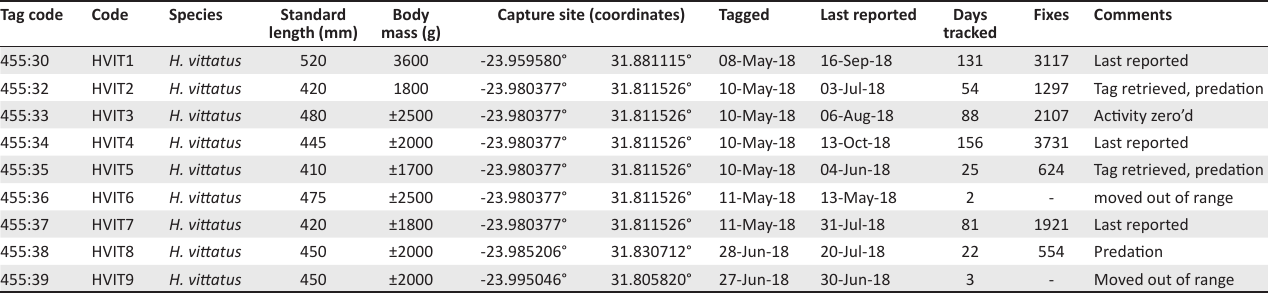
TABLE 1: Summary data for Hydrocynus vittatus individuals that were telemeter tagged in the Olifants Gorge, Kruger National Park, in the present study. Tag code